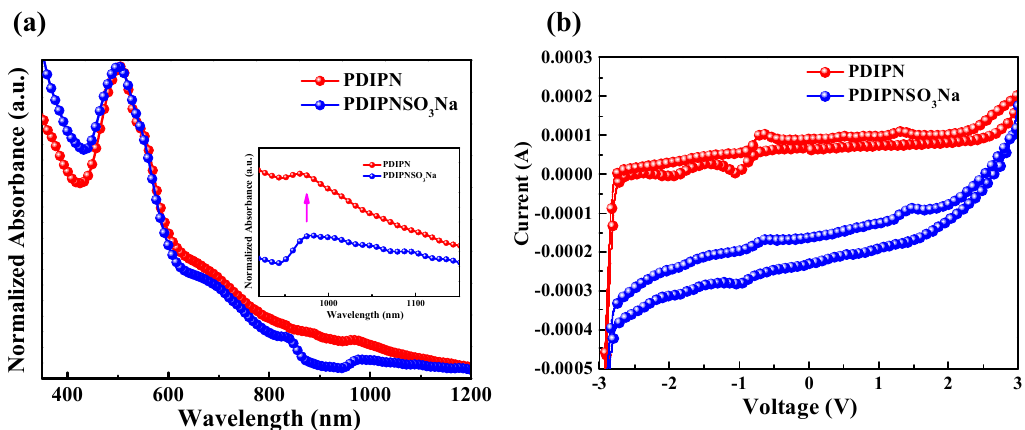
Figure 1. ( a ) UV–Vis absorption and ( b ) cyclic voltammograms (CV) spectra of PDIPN and PDIPNSO 3 Na films.